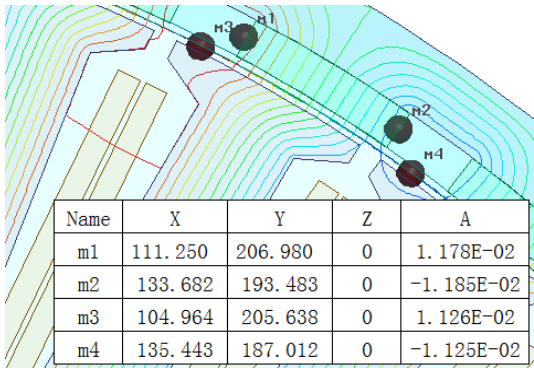
Figure 14. Partial enlarged drawing of flux lines.